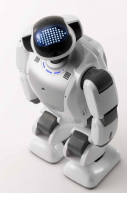
Fig. 12. Small humanoid robot,